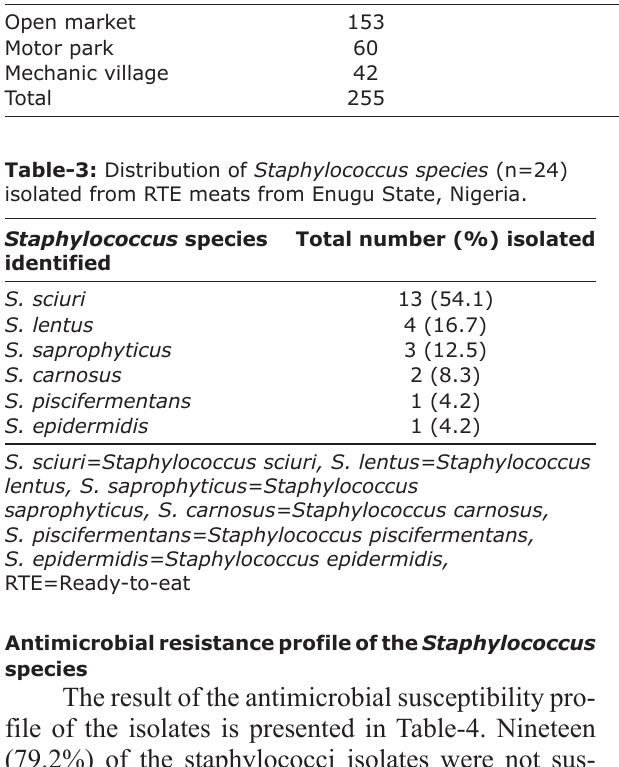
Table-2: Staphylococcus contamination of ready-to-eat meats according to sampling locations. Sampling locations Open market